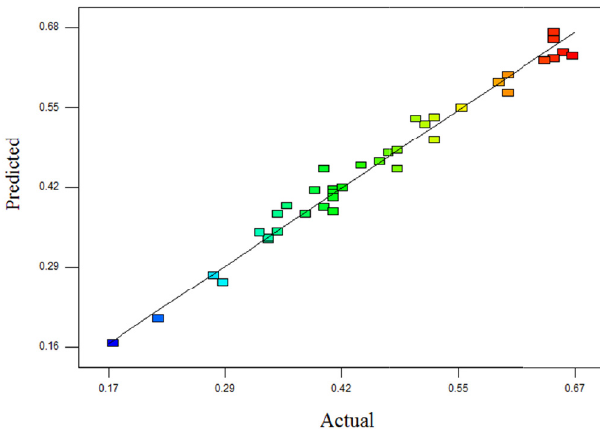
Fig. 5. Predicted vs. actual plot of DF